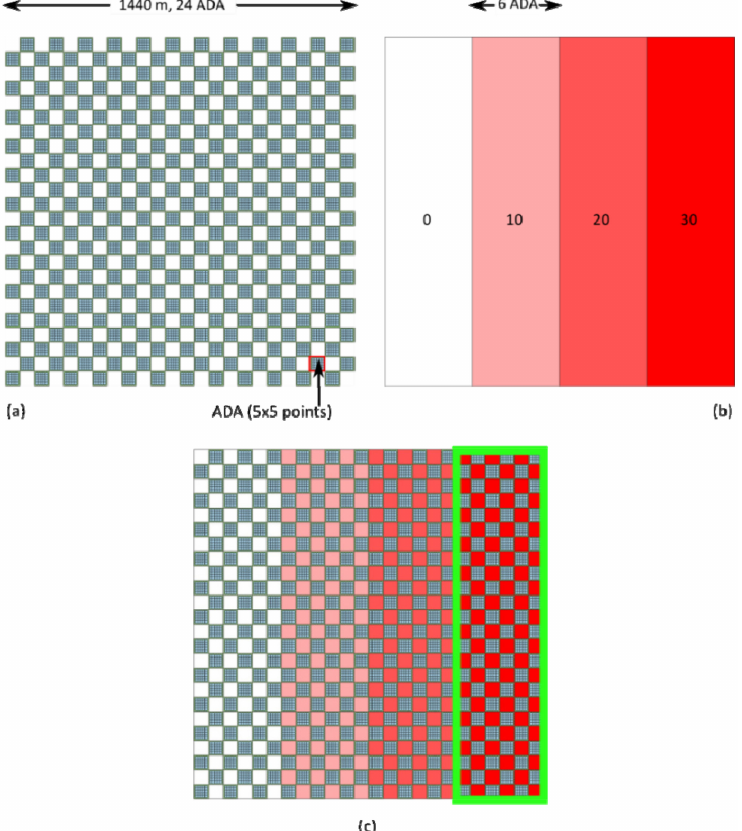
Figure 12. ADAclassifier: synthetic dataset samples. ( a ) represents the checkerboard pattern for ADA, while ( b ) shows the stripes with values for the horizontal components of the movement. The green rectangle in ( c ) depicts the area where positive results for the landslides algorithm should be expected since there the conditions set by the algorithms are satisfied. Source: